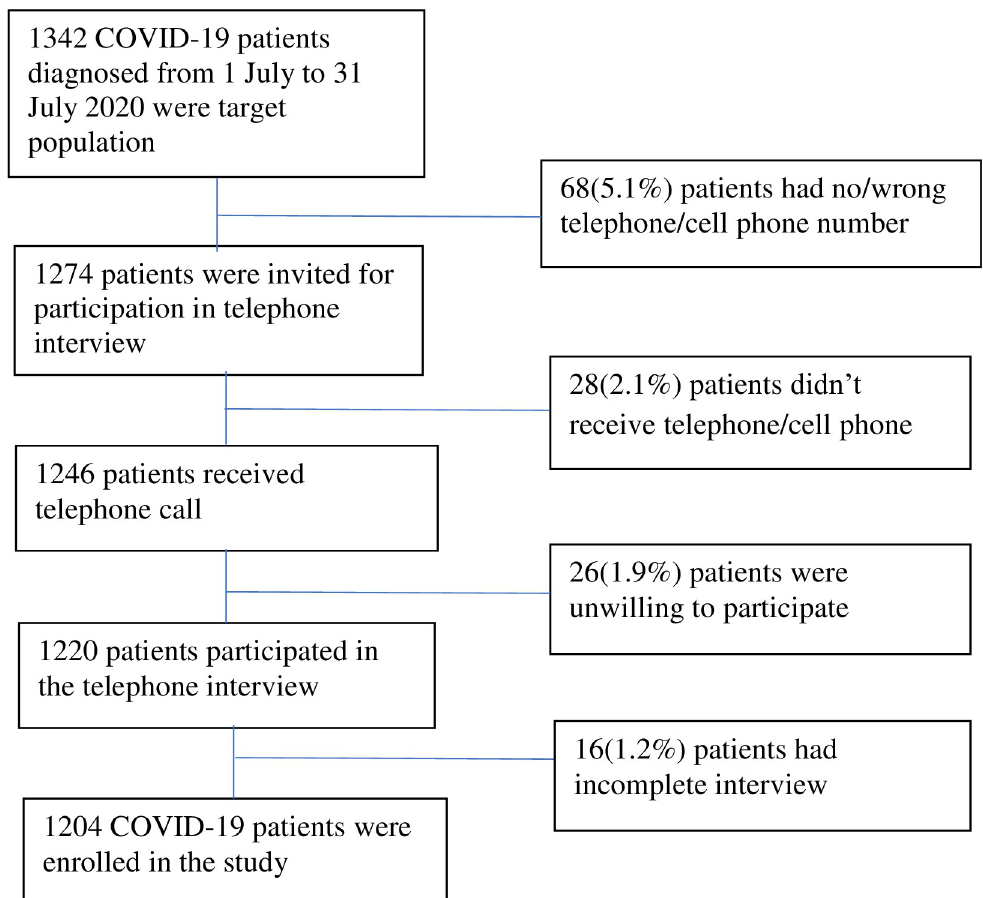
Fig 1. Flowchart of the study participants (COVID-19